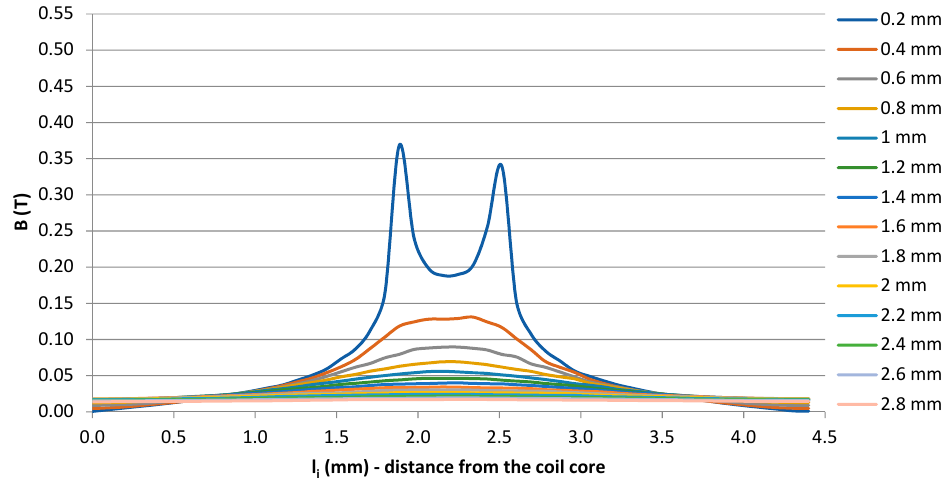
Figure 7. Magnetic induction distribution in dependency on the distance from the air gap and the length along the air gap for inductor described by situation Figure 4b. As described above, the evaluation of induction took place longitudinally to the core. Figure 5 as an example indicates a red line connecting the measurement points, while this line is located at 0.4 mm from the core towards the winding. Thus, the legend of these simulation images is the distance of the measuring lines from the core.